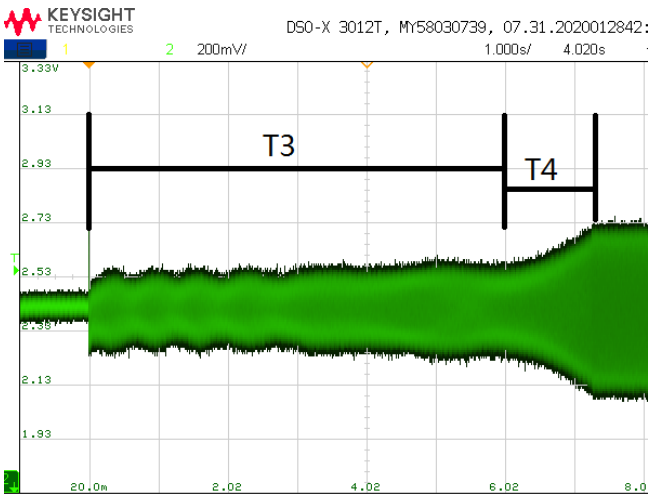
Figure 21. Amplitude change during